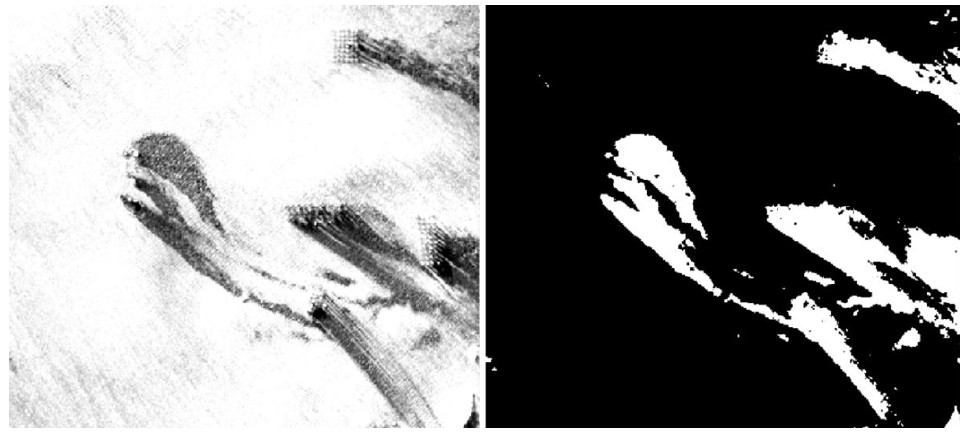
Figure 6. A Sentinel-2 image captured on 27 July 2019 showing Ildir Bay (Site 3). Band 8 ( left ) and biogenic oil film mask after applying the threshold (right). Several features are considered to contribute to the discrimination between oil slicks 213 and similar features, referring to the geometrical, physical and textural characteristics of 214